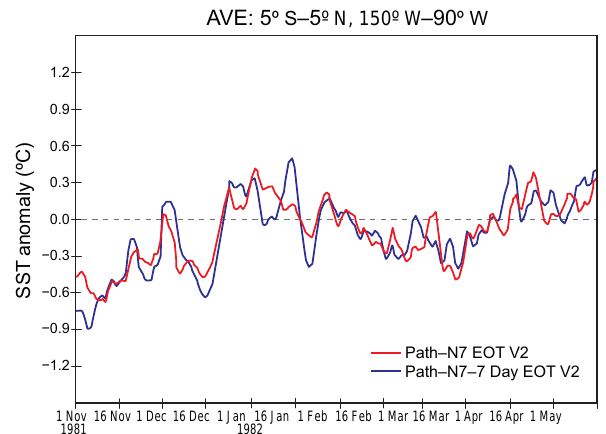
Figure A5. Daily OI Nino-3 anomalies using EOT bias correction with 15 and 7 days of data. “N-7” indicates that NOAA-7 satellite SST data are used.